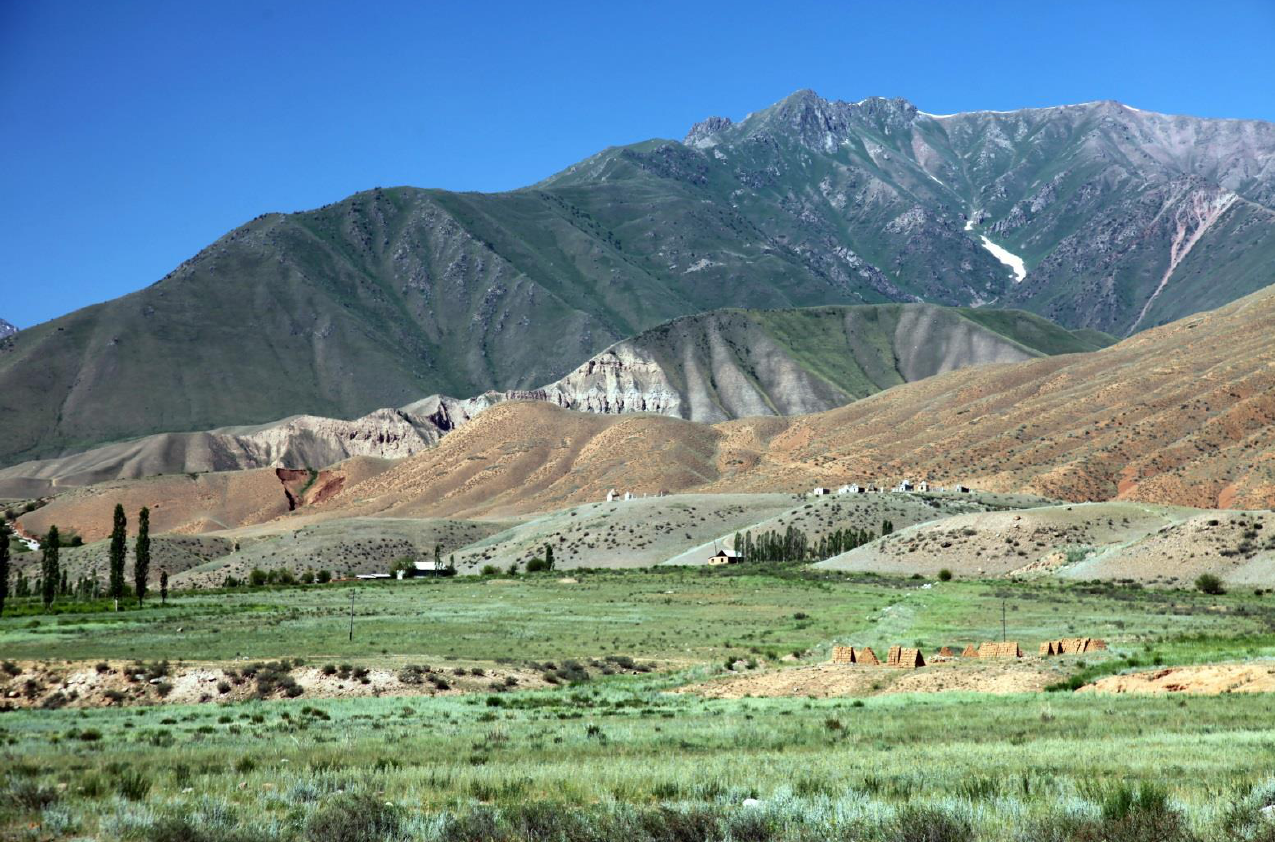
Fig. 4. Central part of Dzhumgaltoo Mts. near Sary-Oi, almost all vertical zones are